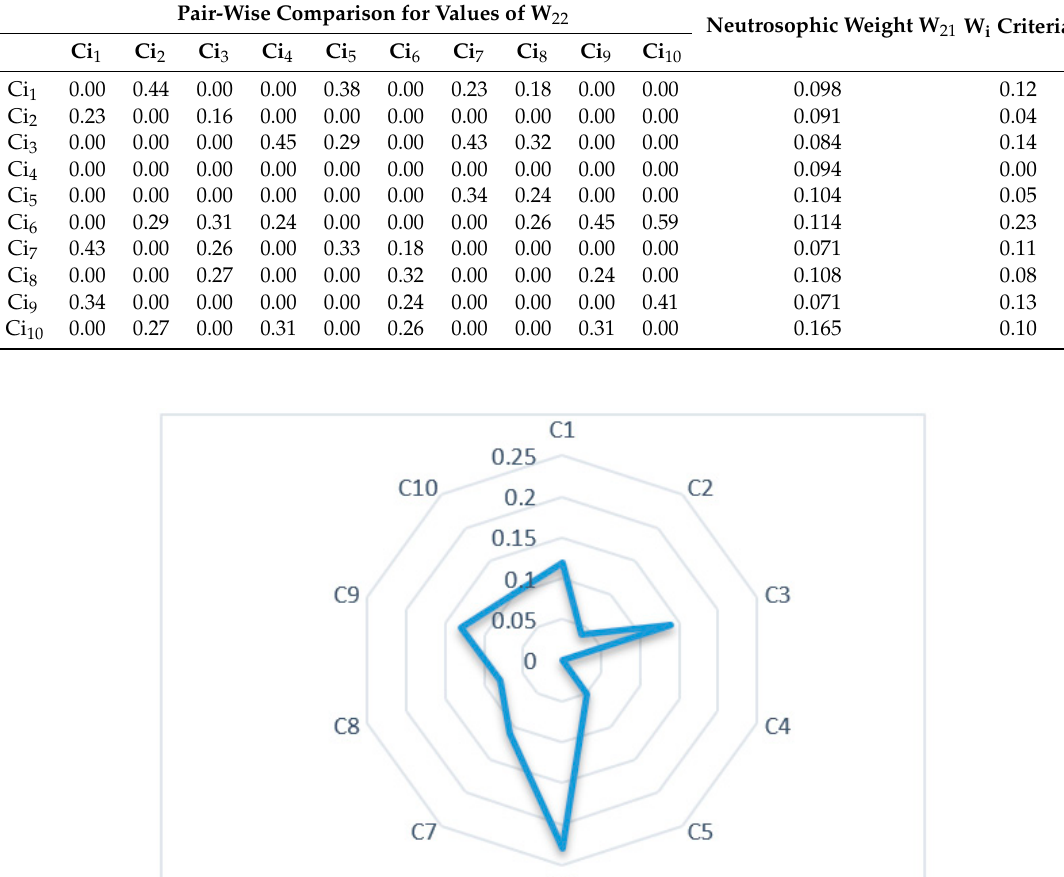
Table 18. Deneutrosophication values of the judgments matrix.